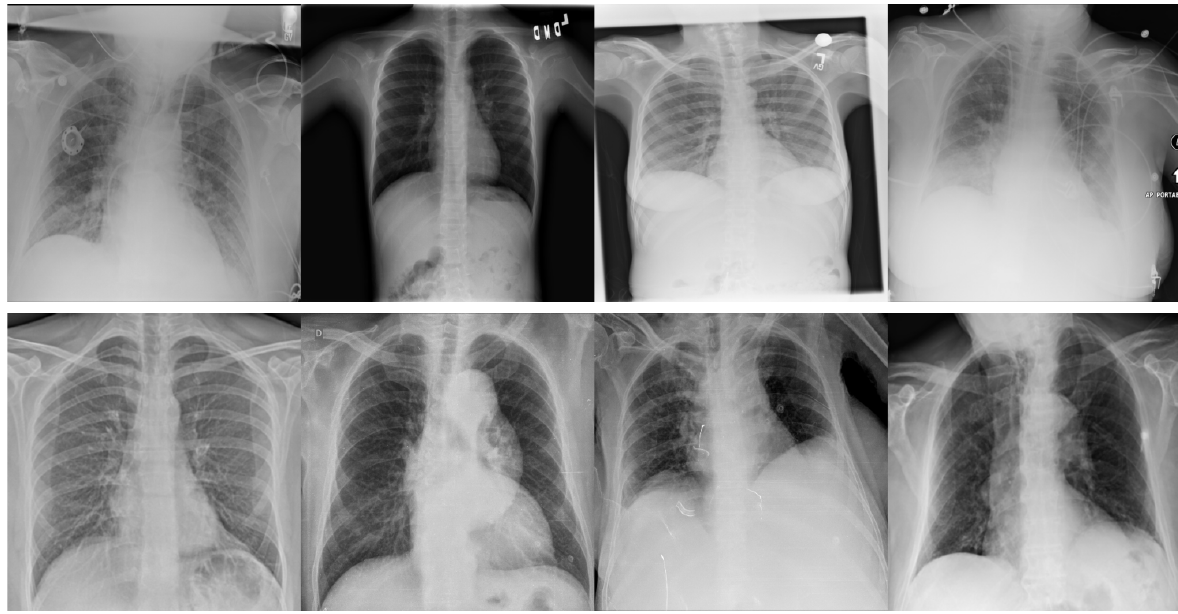
Figure 1. Example chest X-ray images from COVIDx CXR-2. First row is SARS-CoV-2-negative patient cases, and second row is SARS-CoV-2-positive patient